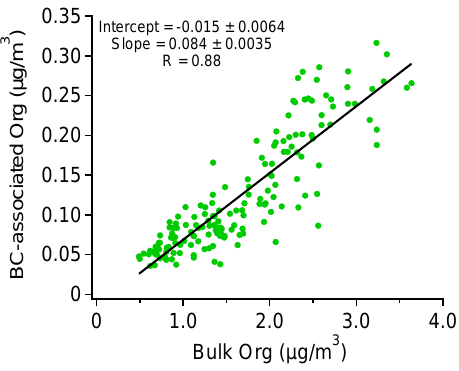
Figure 11. Comparison between organics associated with rBC (measured by SP-AMS with laser vaporizer only) and the non- refractory organics in the bulk measurement (by HR-ToF-AMS) af- ter heating at 250 ◦